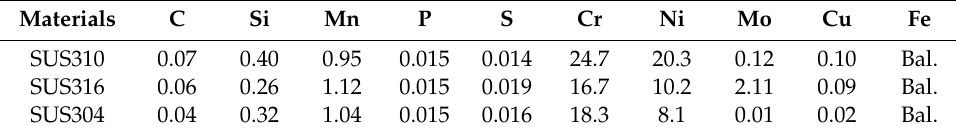
Table 1. Chemical composition of stainless steels (wt.